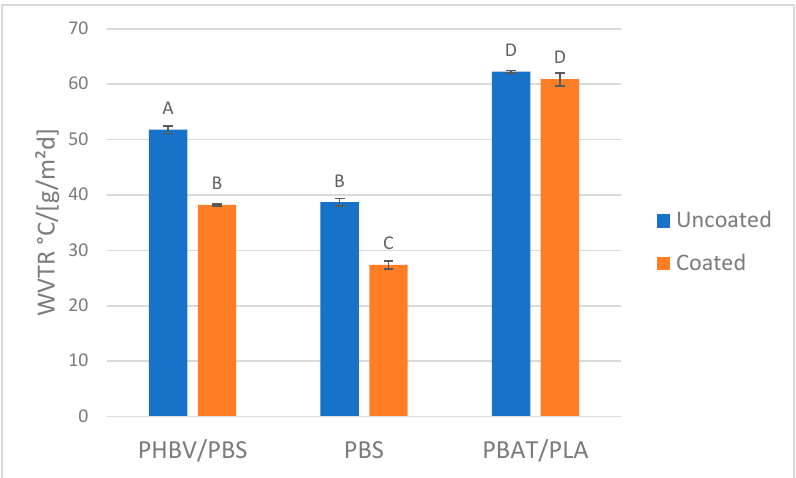
Figure 6. WVTR values of coated and uncoated films. The same letter on the column means that values were not significantly different (confidence level 95%).